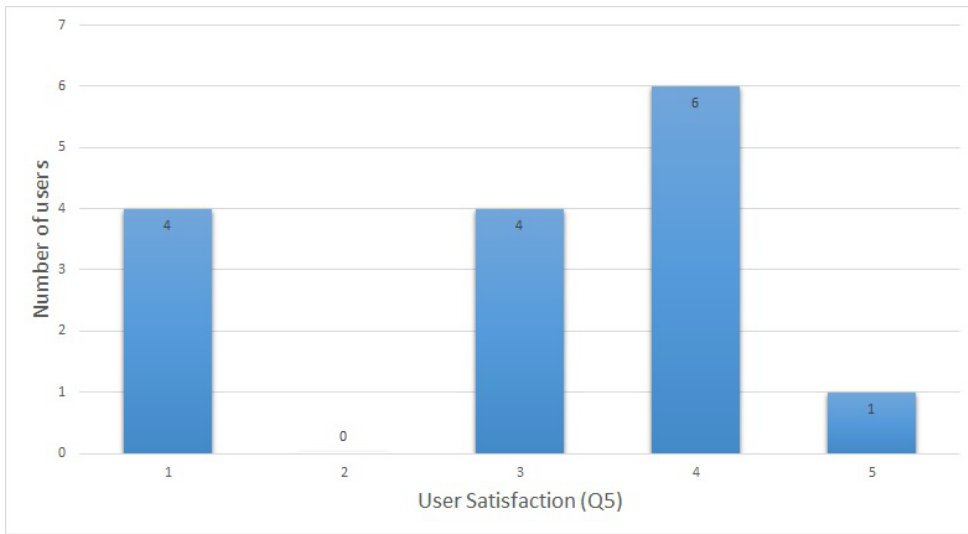
Figure 5. The bar plot reports the level of user satisfaction investigated through Q5 in the case of robot critical